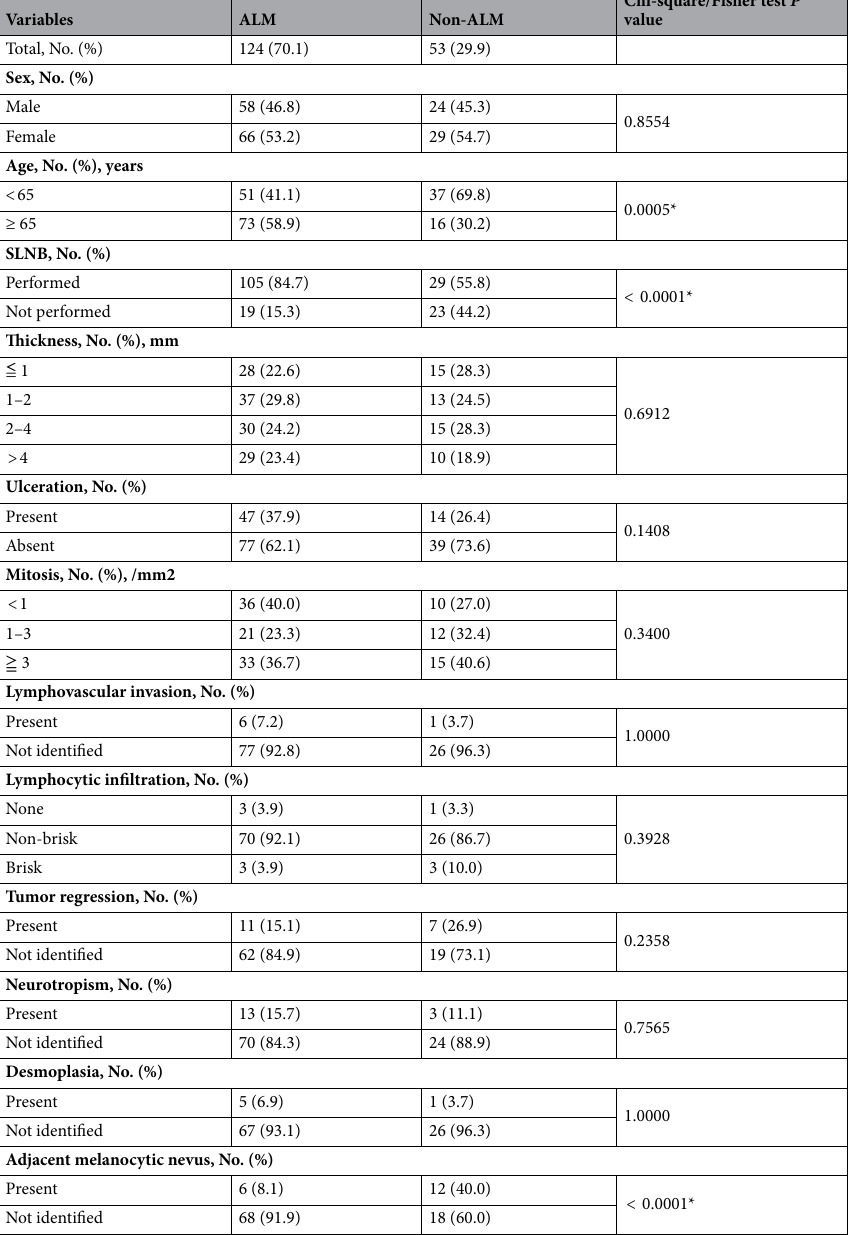
Table 1. Clinicopathological characteristics of ALM and non-ALM cutaneous melanoma. ALM acral lentiginous melanoma, SLNB sentinel lymph node biopsy. *Statistically significant with Chi-square/Fisher test P values <